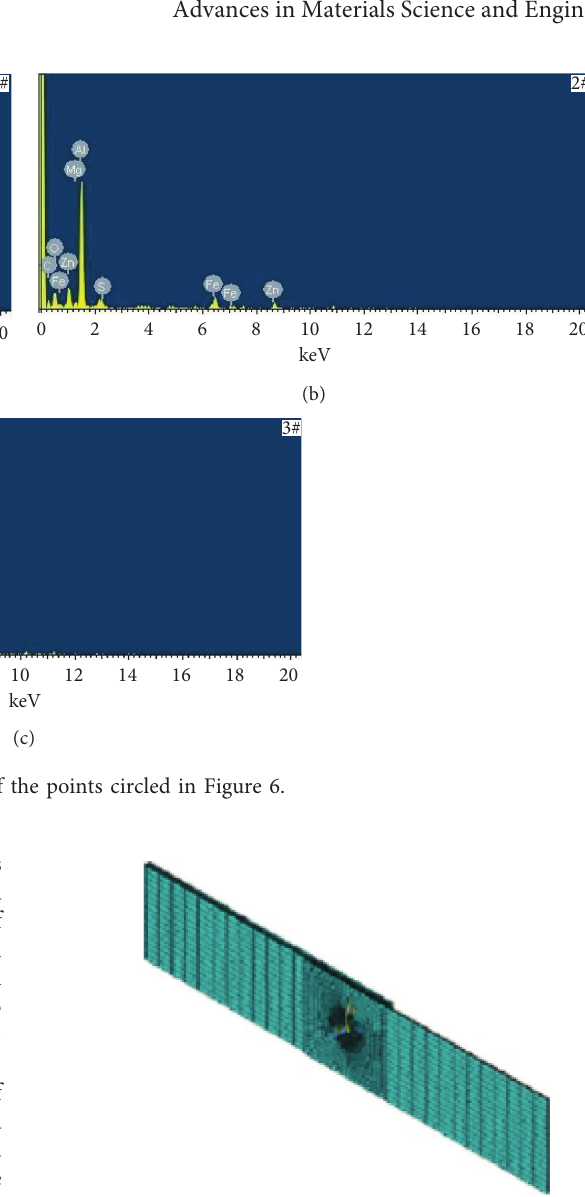
Figure 8: Finite element mesh